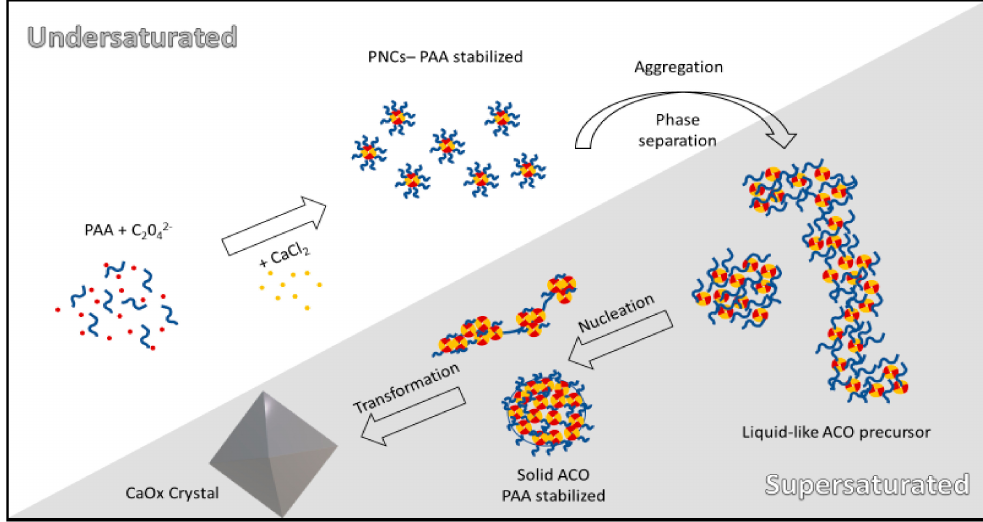
Scheme 1. Illustration of the in vitro crystallization of CaOx showing the resultant nano/micro particles during pre-and post-nucleation stages of CaOx and tentative molecular mechanism for the stabilization of amorphous ACO